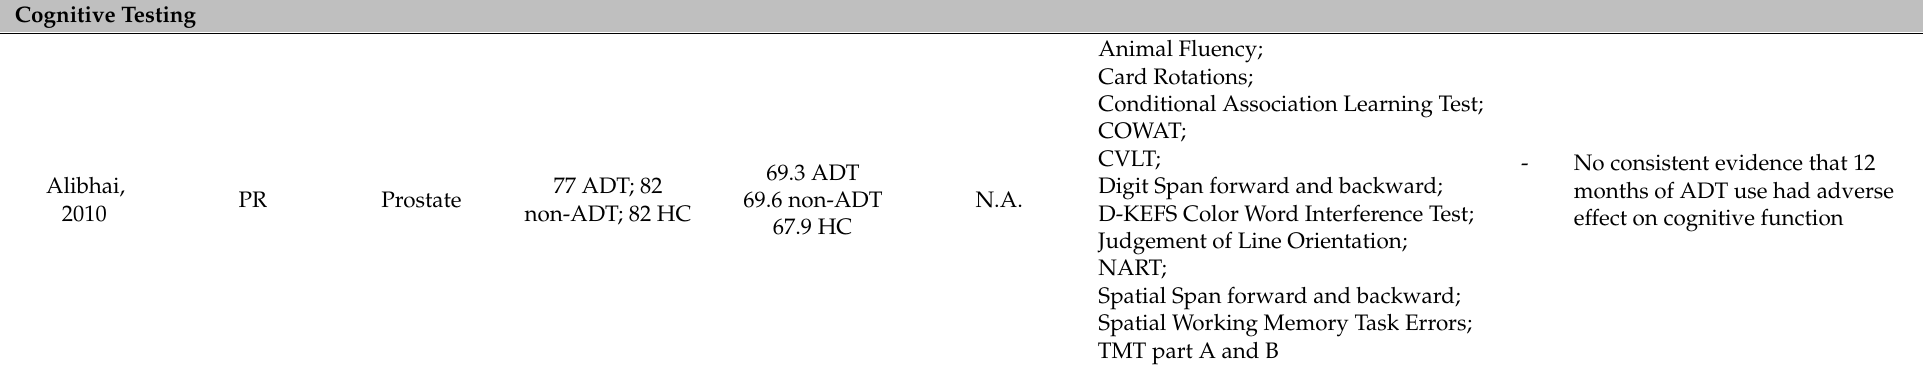
Table A2. Overview of cognitive studies in older cancer survivors according to the systematic literature